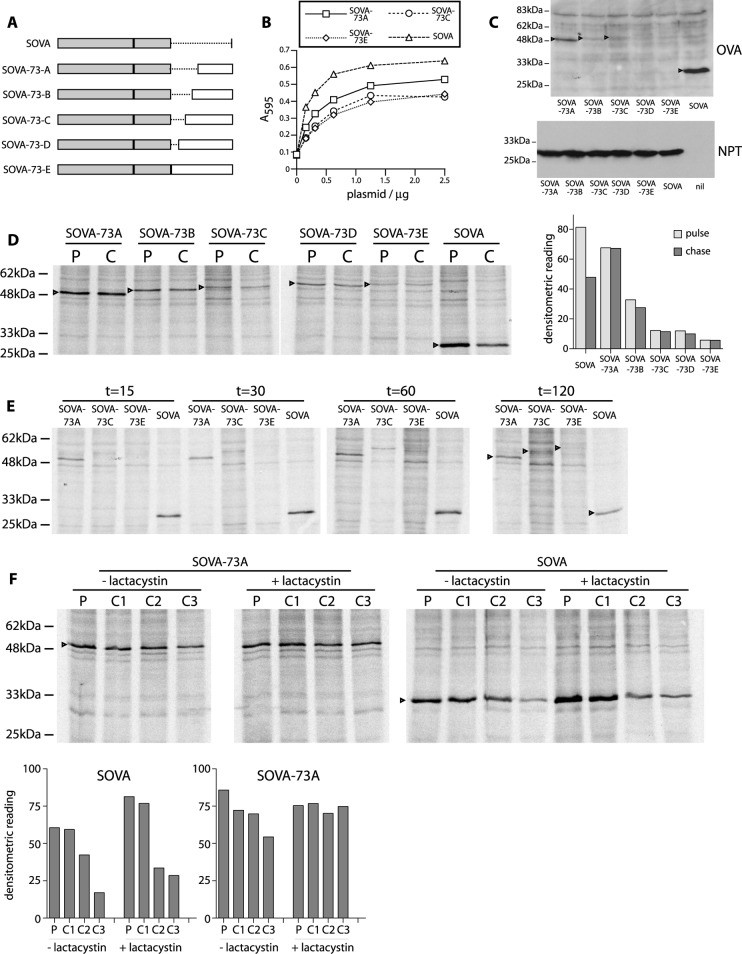
Inhibition of Epitope Presentation by ORF73 Fusion to OVA Correlates with Reduced Translation of the Fusion Protein(A) N-terminal ORF73 truncations equivalent to those in Figure 1E were fused in frame to the C-terminus of OVA amino acids 41–325, thereby removing both the OVA signal sequence and the ORF73 nuclear localisation signal.(B) Serial dilutions of an expression plasmid containing each fusion gene were transfected into L929-H2-Kb cells as in Figure 1. SIINFEKL presentation was assayed using beta-galactosidase production from the B3Z hybridoma.(C) Equivalent transfected cells were immunoblotted with an anti-OVA rabbit serum (OVA). Fusion products are indicated by arrowheads where visible. Parallel immunoblots for neomycin phosphotransferase II (NPT), which is expressed from a different promoter of the same plasmid (pcDNA3), were used to control for transfection efficiency. The endogenous neomycin phosphotransferase II expressed by 293T cells was not visible at this exposure. One of three equivalent experiments is shown.(D) Forty-eight hours after transfection with the constructs indicated, 293T cells were pulse-labelled (P) for 30 min with 35S-cysteine/methionine, followed by a 2-h chase (C) with excess unlabelled cysteine/methionine. OVA derivatives were then immunoprecipitated with an OVA-specific rabbit serum and resolved by SDS-PAGE. The specific bands corresponding to each fusion protein are indicated by arrowheads. The graph shows densitometry readings for each band.(E) 293T cells transfected with selected fusion proteins were labelled for a variable period (15–120 min) as indicated. OVA derivatives were then immunoprecipitated and analysed as in (D). Arrowheads show the predicted position of the relevant fusion proteins for the 120-min label samples.(F) Either SOVA-ORF73A or SOVA was transfected into 293T cells. Forty-eight hours later the cells were pulse-labelled (P) for 15 min with 35S-cysteine/methionine, followed by a 15-min (C1), 45-min (C2), and 105-min (C3) chase with excess unlabelled cysteine/methionine. This was done in the presence or absence of 100 μM lactacystin. The graph shows densitometry readings for each specific band.